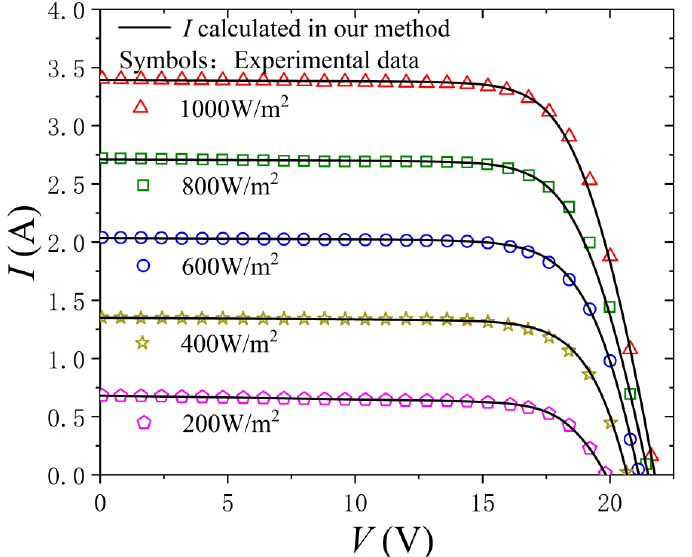
Figure 7. I-V characteristics measured and calculated, respectively, for the thin-film SM55 PV panel in different irradiance conditions.